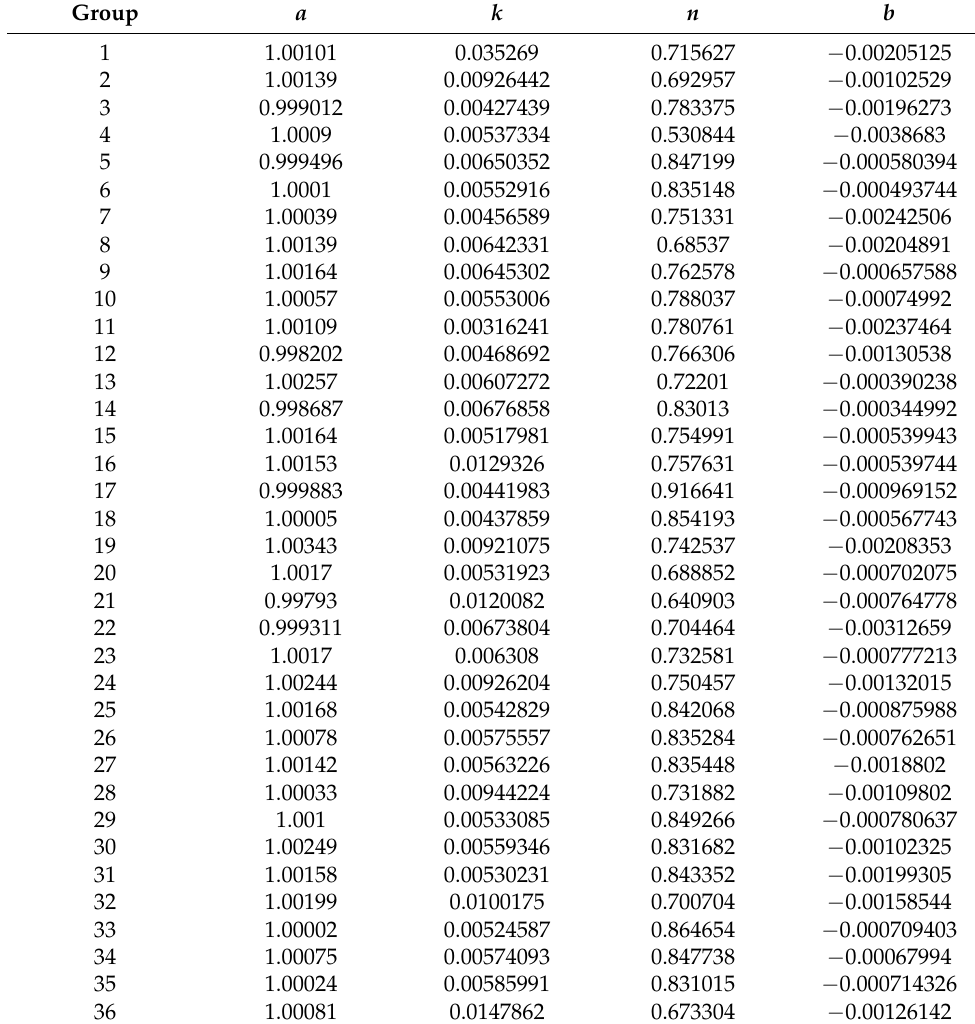
Table 6. Coefficients of the Midilli drying accumulated temperature